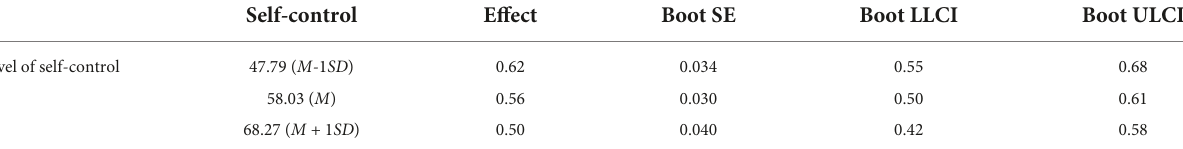
TABLE 5 Mediating effects of self-control at different